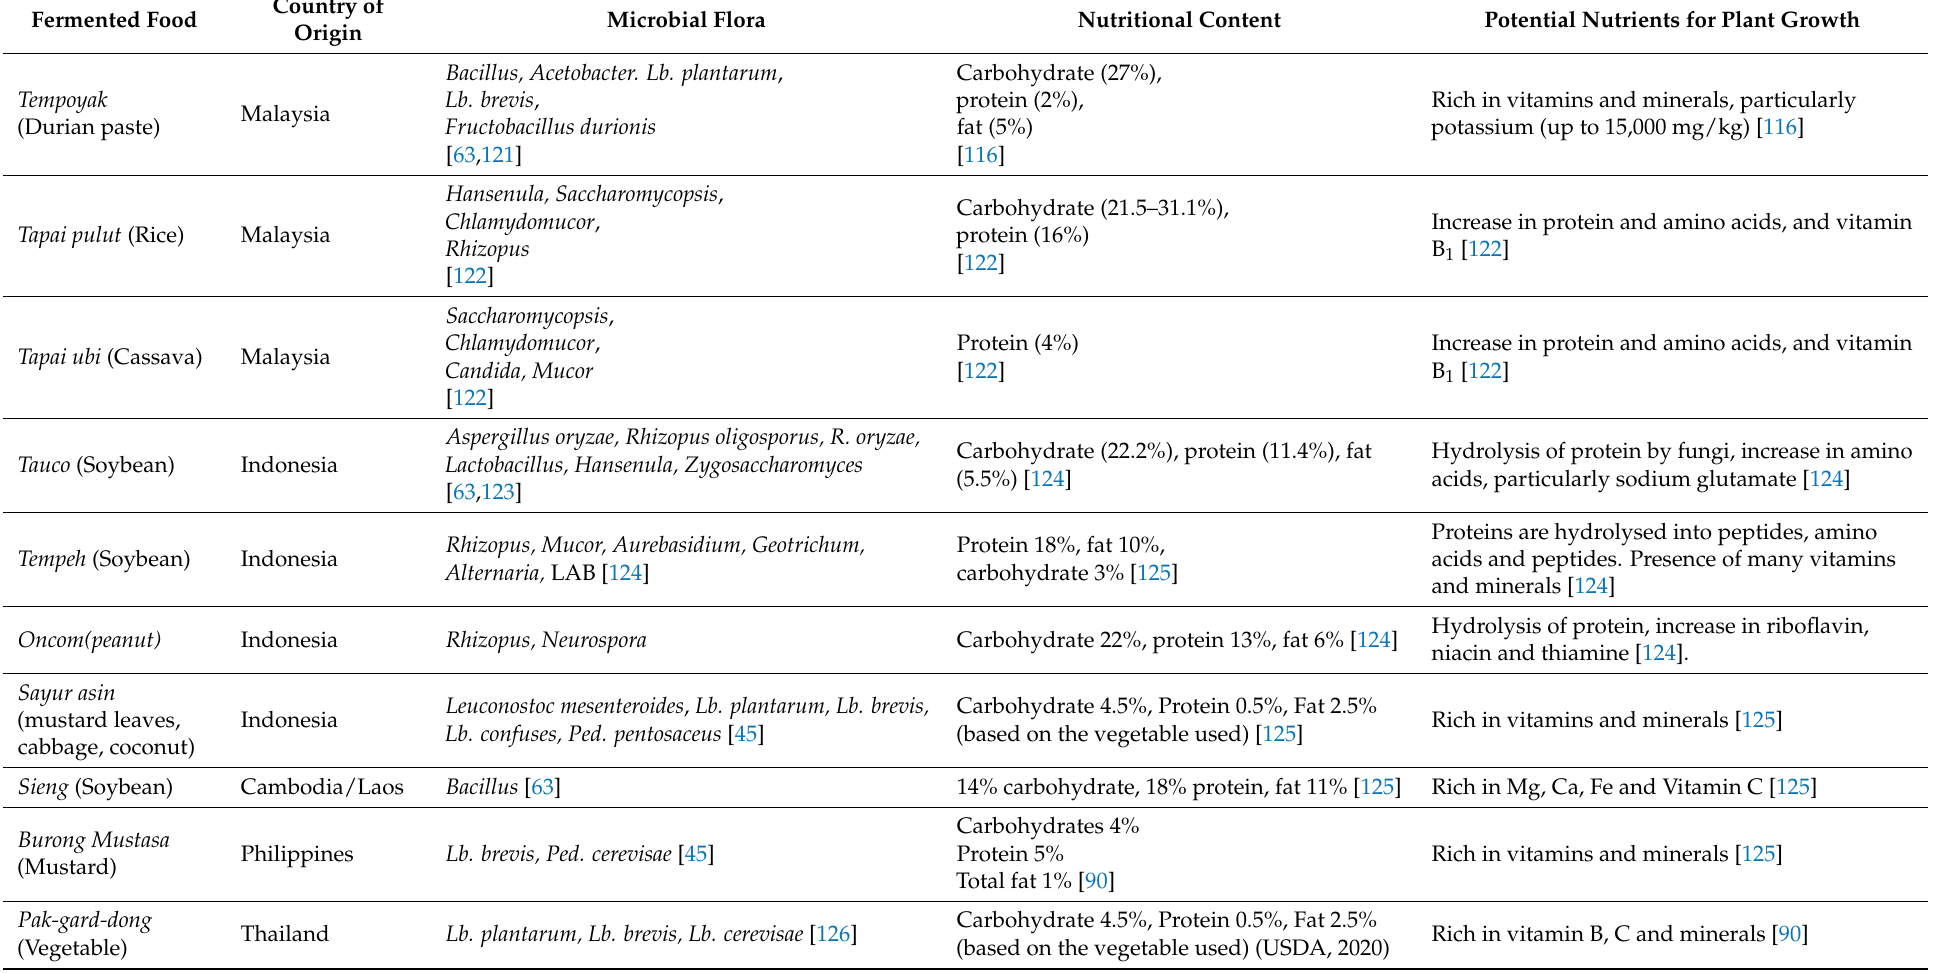
Table 3. Examples of plant-based fermented food in Southeast Asia with microbial flora and nutritional